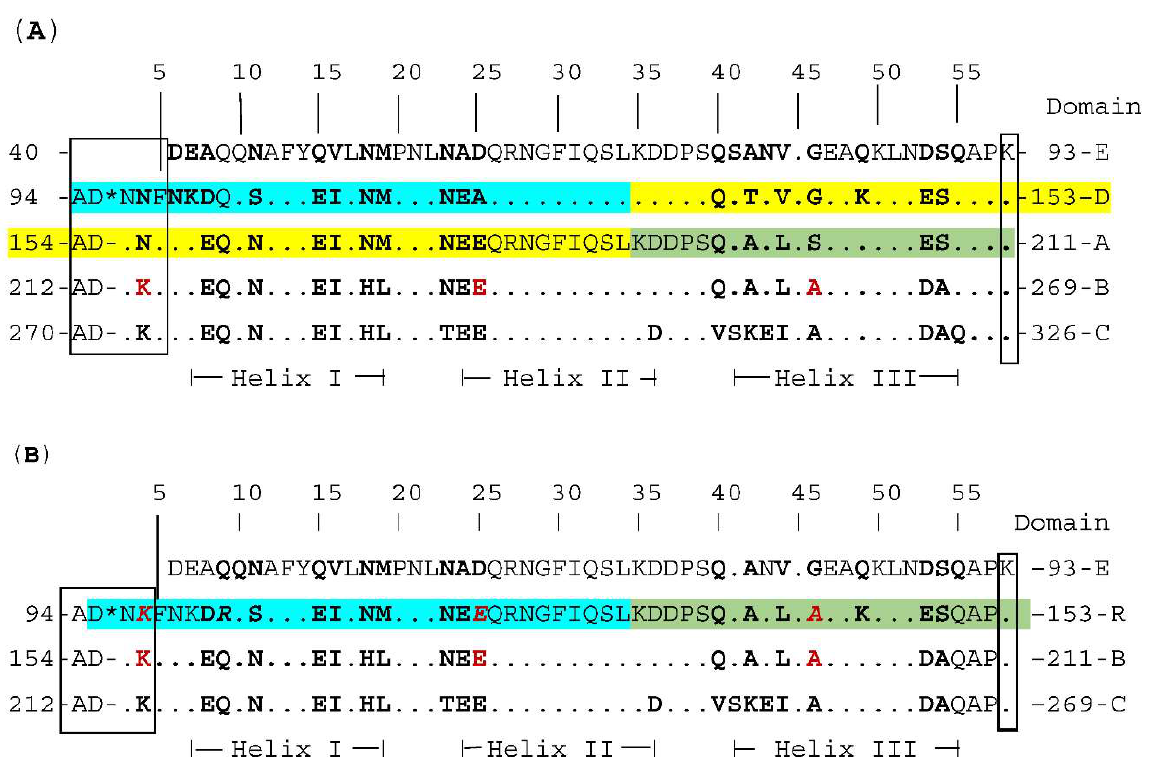
Figure 1. Structural features of protein A (SpA) domains (sequence aliment protein A binding domains) in S. aureus NCTC8325 ( A ) and S. aureus SA943 ( B ). Note: Letters designate structural domains according to Jo. A. Capp et al. (2014) [46]. Letter R denotes the formed recombinant domain. Dots indicate identical amino acids; domain areas differing in amino acid sequences are marked in bold type. The linker region between domains is boxed in black. Each of the domains consists of 3 helix bundles connected by short linkers; * Amino acid insertion (AQQ) between domains E and D ( A ) or E and R ( B ). The part of the D domain involved in the formation of R domain is highlighted in blue; the part of the A domain involved in the formation of the R domain is highlighted in green; the deletion region of D and A domains is shown in yellow. The original amino acid substitution in the R domain is highlighted in black italics; red italics highlight amino acids in the R domain that are specific to domain B and C, but representing substitutions in relation to domains D and A; Amino acids that are specific for the B domain and absent in the fragments of the D and A domains that form the R domain are highlighted in red normal